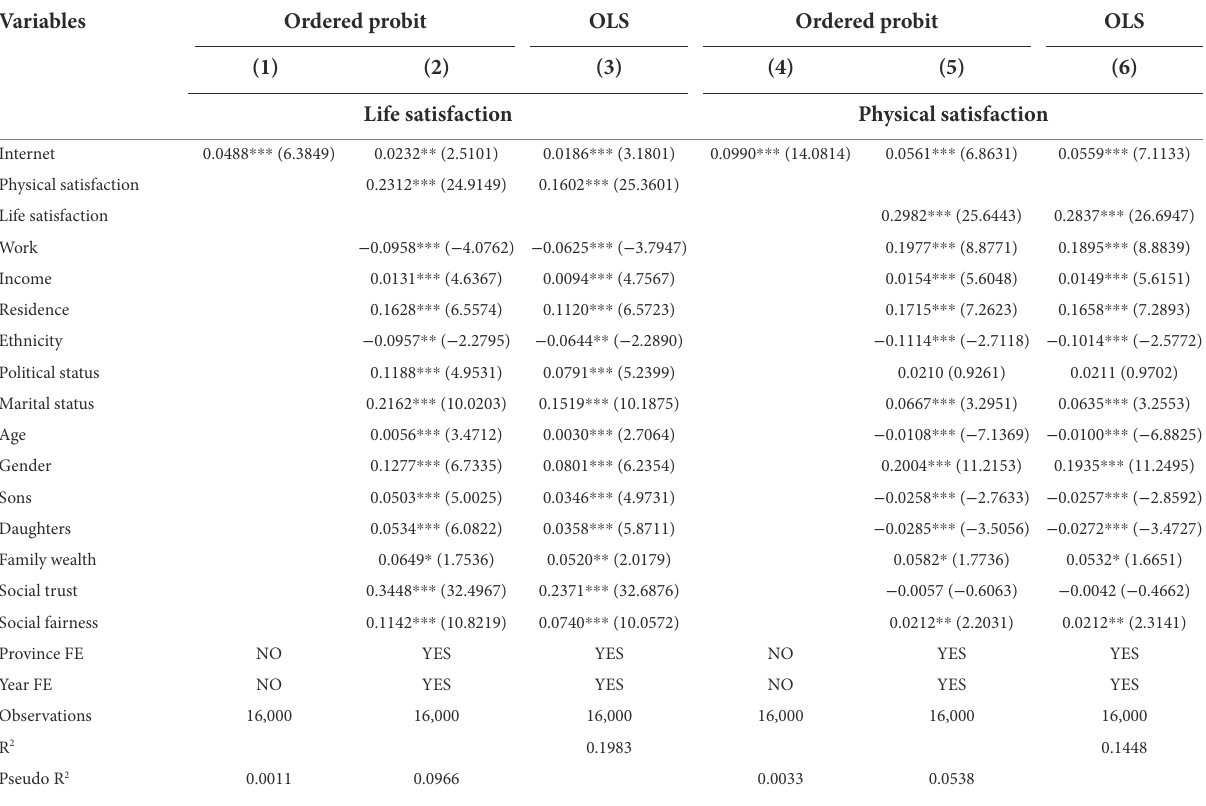
TABLE 2 Benchmark regression